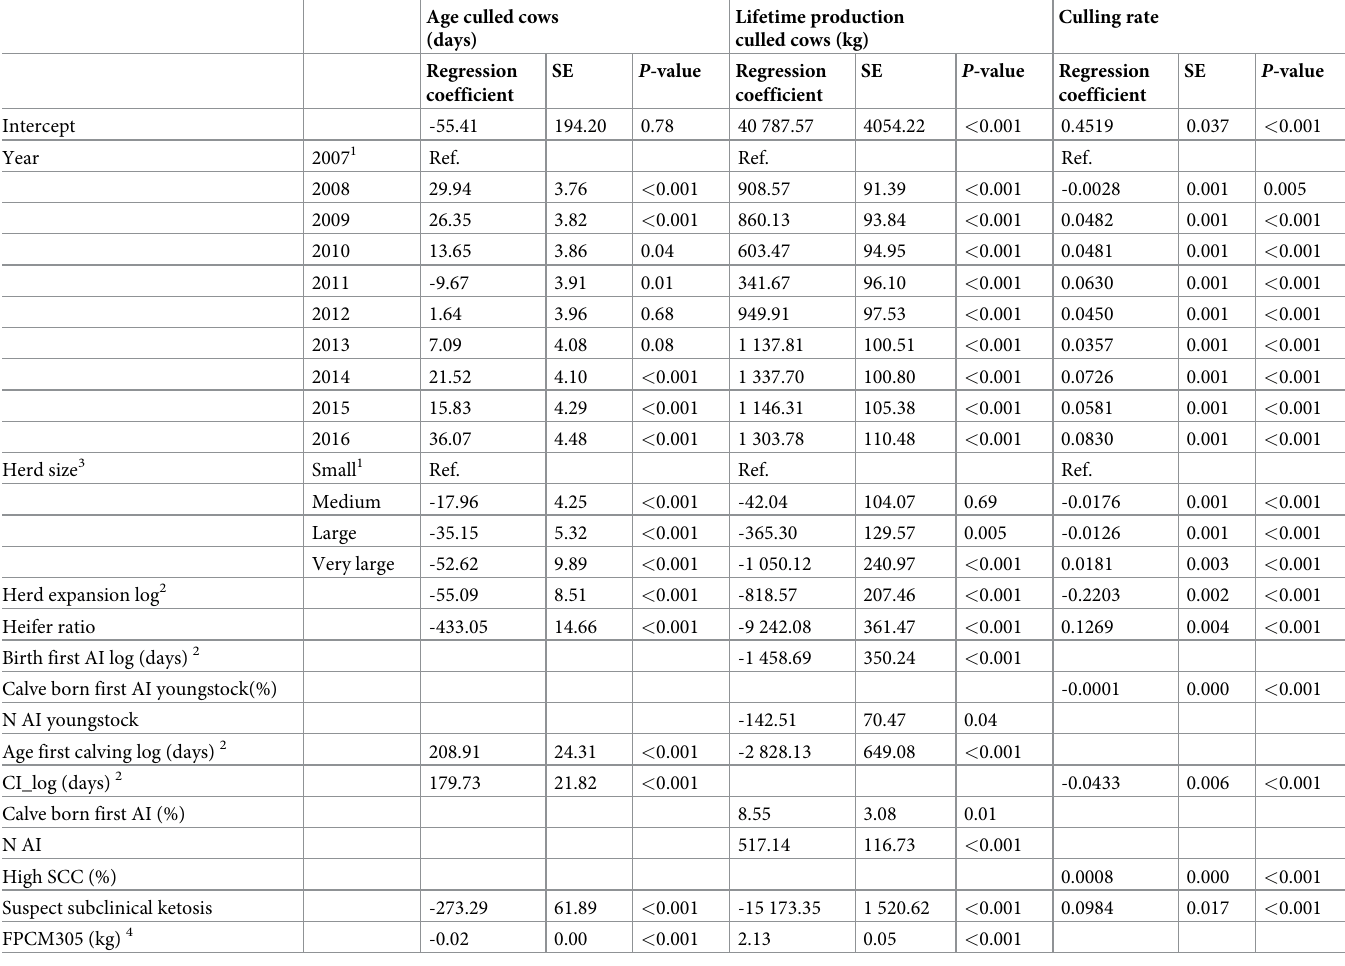
Table 3. Results of the mixed linear regression models on the association of age and lifetime milk production of culled milking cows and culling rate with herd per- formance indicators. Age culled cows